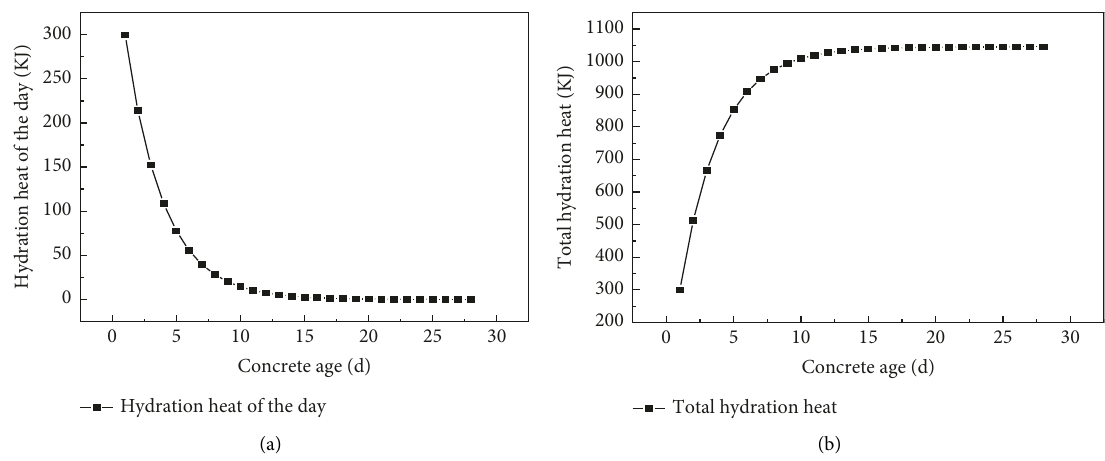
Figure 3: Hydration heat curve: (a) hydration heat released on the day and (b) total hydration heat.